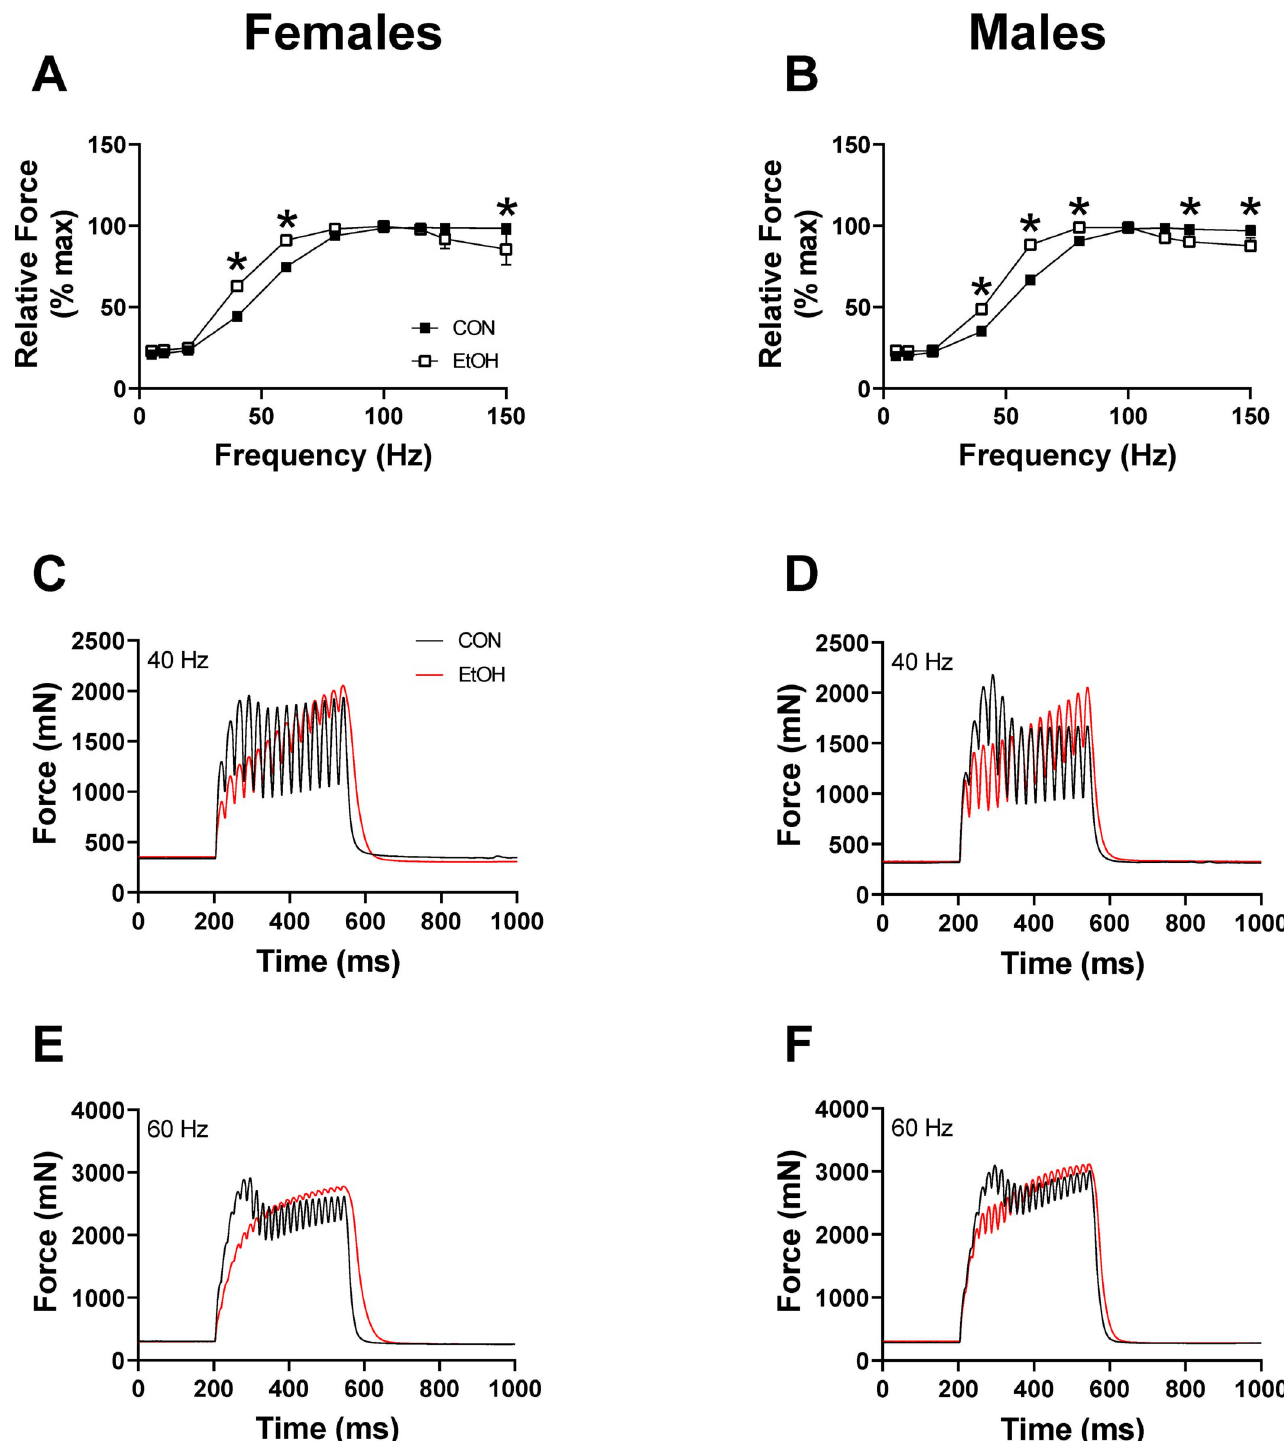
Fig 2. Percentage of maximal force generation 1 hour after alcohol intoxication. The force generated as a percentage of maximal force for females (A) (p � 0.0016), and males (B) (p � 0.0304), 1 hr after alcohol intoxication. Force traces at 40 Hz and 60 Hz for females (C, E) and males (D, F), at 1 hr post alcohol binge. Data in panel A and B were analyzed by 2-way ANOVA and are presented as mean ± SEM. � EtOH significantly different than sex-matched CON at that frequency ( p < 0.05).